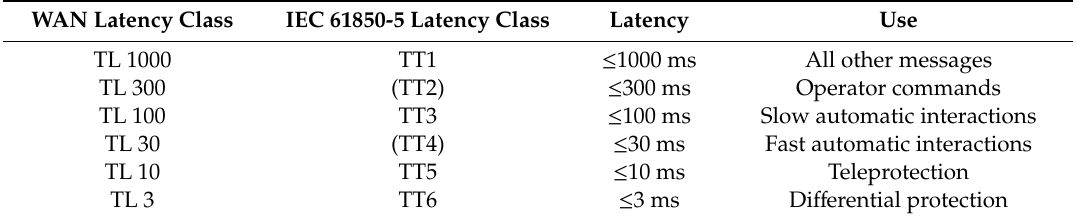
Table 5. Latency classes for WANs (wide area